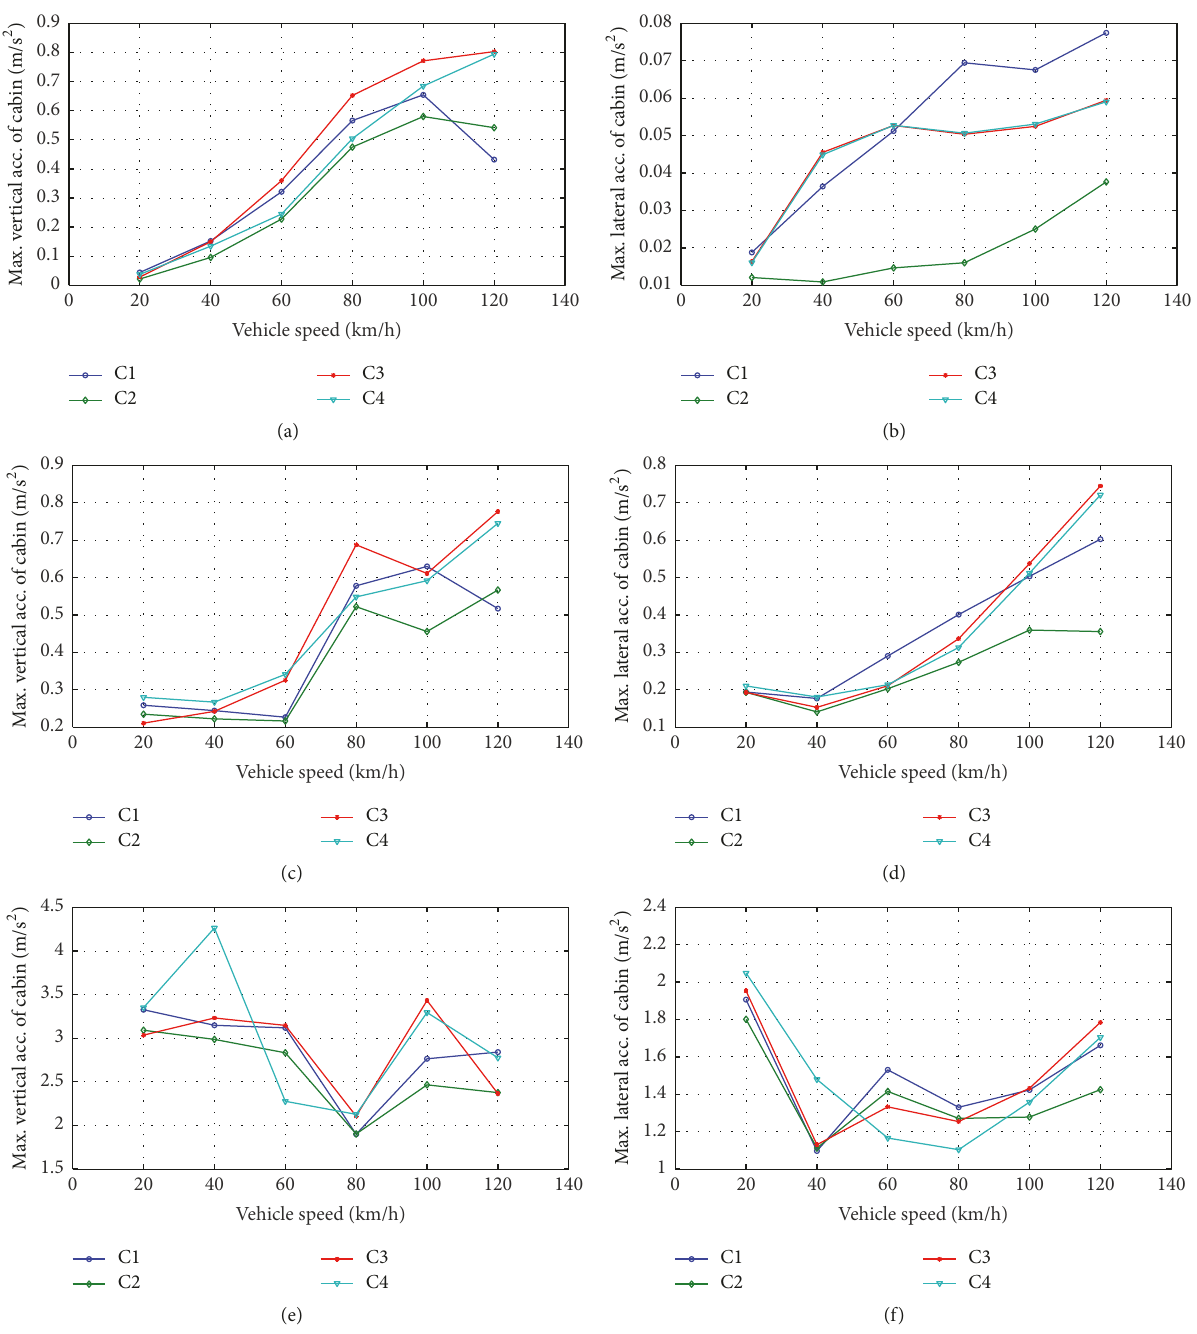
Figure 23: Maximum acceleration of cabin at the four points: (a) vertical acceleration ( U = 0m/s), (b) lateral acceleration ( U = 0m/s), (c) vertical acceleration ( U = 10m/s), (d) lateral acceleration ( U = 10m/s), (e) vertical acceleration ( U = 30 m/s), and (f) lateral acceleration ( U = 30